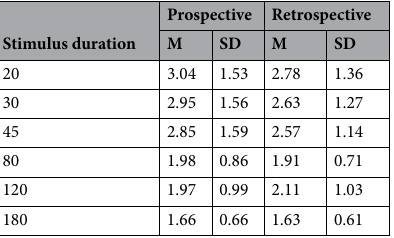
Table 2. Mean (SD) of PoT judgment for the different stimulus durations in the prospective and the retrospective condition.